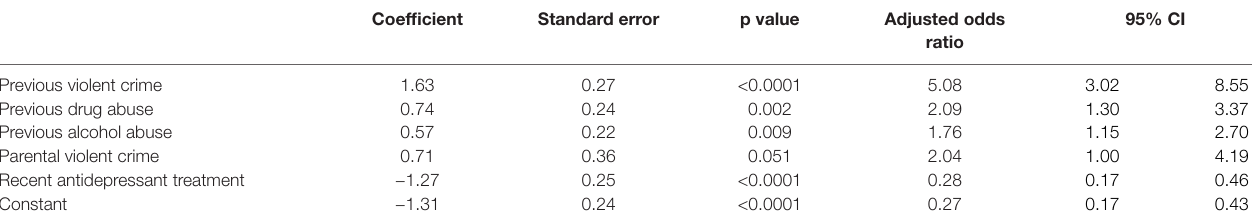
TABLE 4 | Association between risk factors and violent behavior from logistic regression after multiple imputation and variable